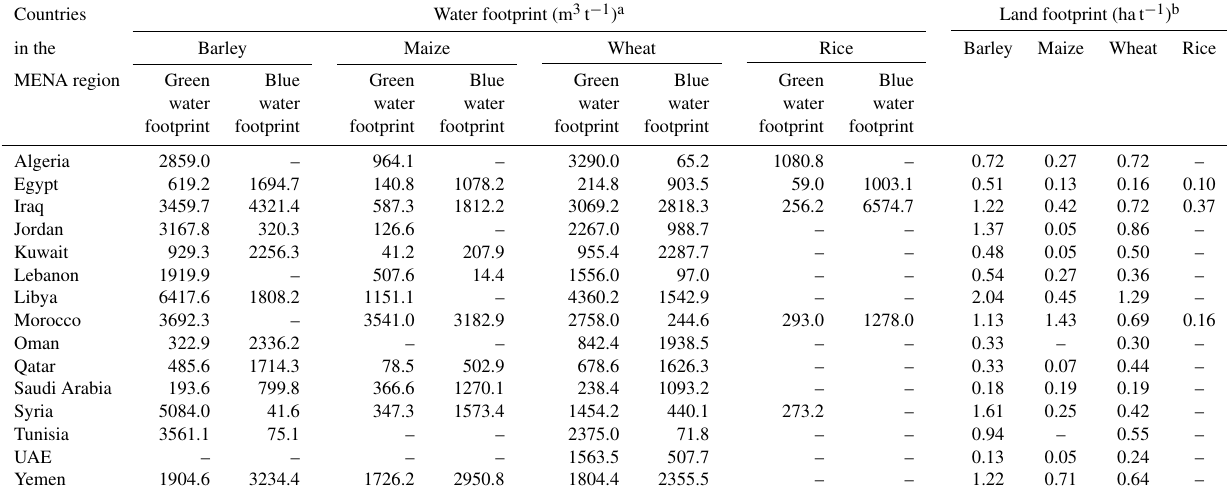
Table 2. Water and land footprints of four major crops in the MENA region. Countries in the Barley Maize Wheat Rice Barley Maize Wheat Rice MENA region Green Blue Green Blue footprint footprint footprint footprint footprint footprint Algeria 2859.0